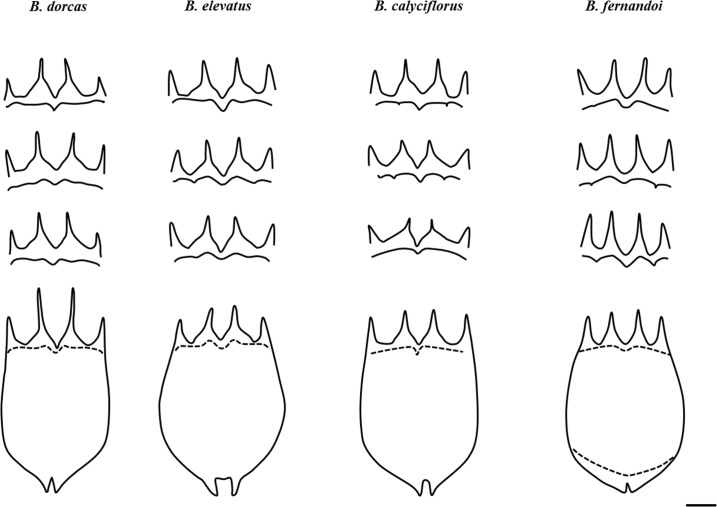
Line drawings of the main variations of the anterodorsal and anteroventral sides encountered for B. dorcas, B. elevatus sp. nov., B. calyciflorus s.s. and B. fernandoi sp. nov.